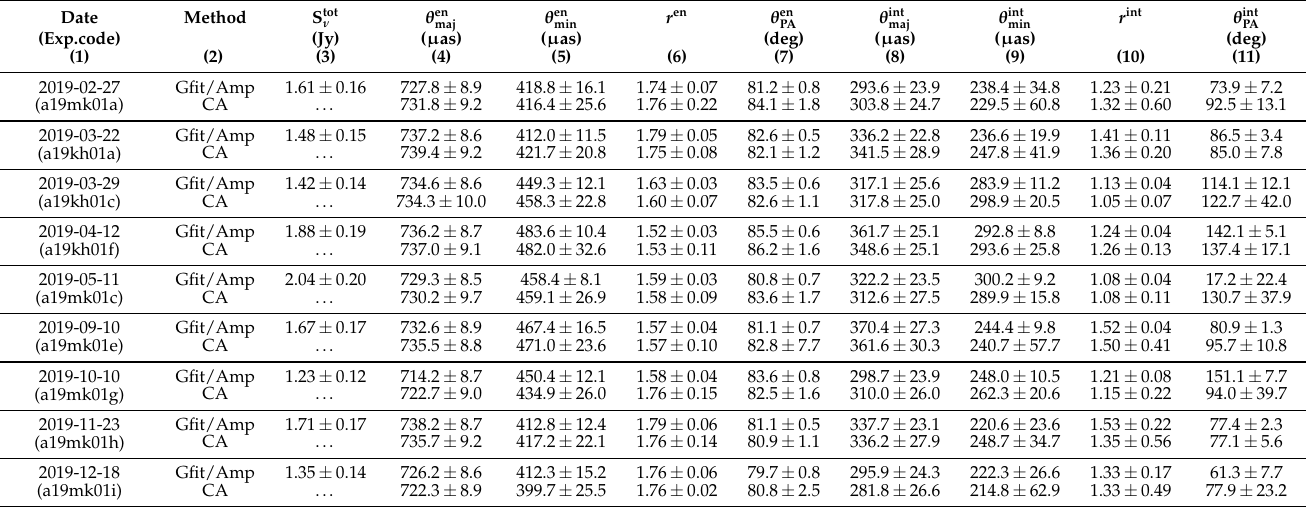
Table 3. Gaussian Model Fitting